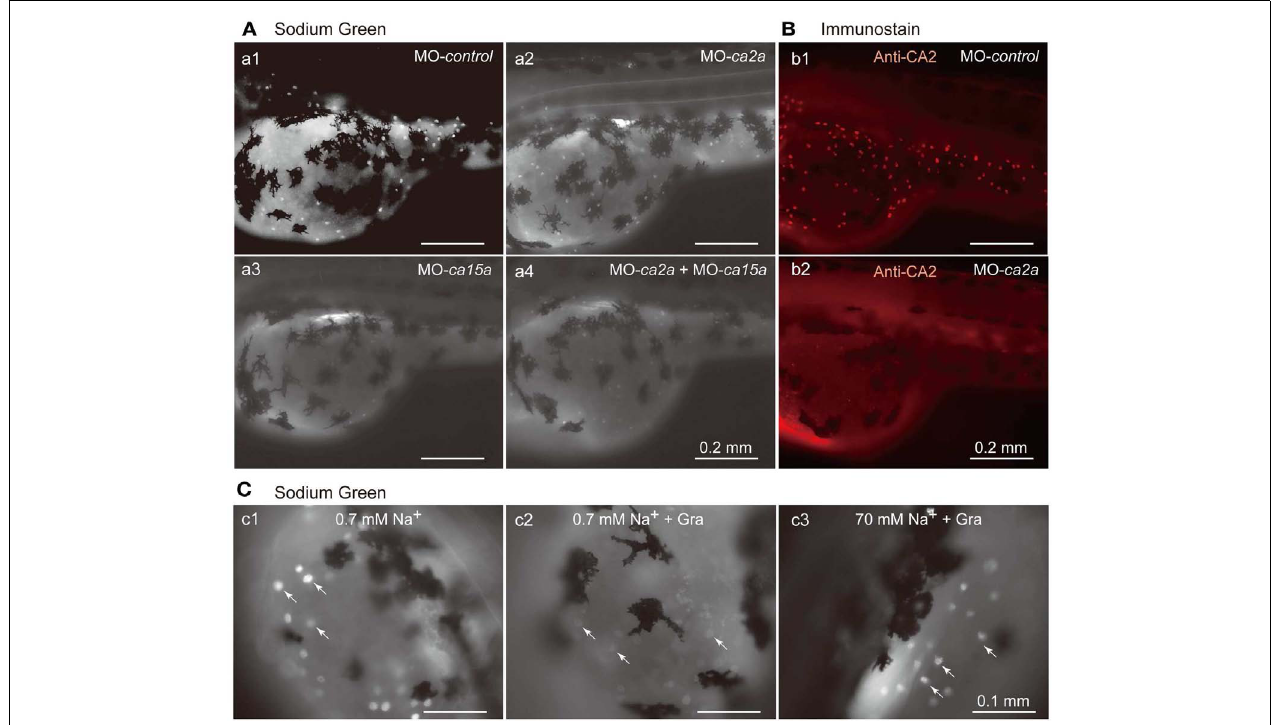
melanocytes. (B) Confirmation of depletion of the CA2a protein in morphants treated with ca2a -MO. Larvae were treated with control -MO (b1) and ca2a -MO (b2) and stained with anti-CA2a antiserum. (C) Sodium Green fluorescence reflecting intracellular concentrations of Na + . Zebrafish larvae were stained with Sodium Green with or without pretreatment with gramicidin (Gra) in the standard culture medium (c1 and c2) and in a high salt medium (c3). Gramicidin was added to equilibrate the intracellular and extracellular Na +